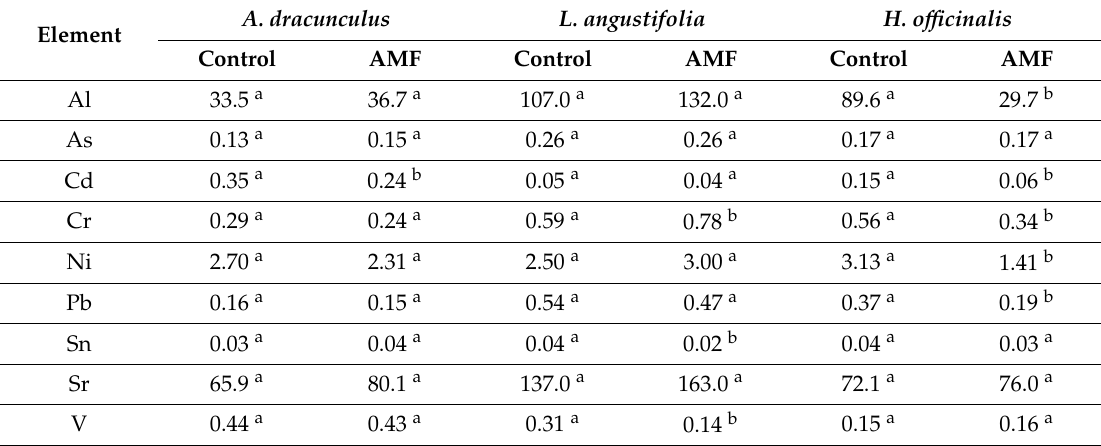
Table 6. Heavy metals content in aromatic plants inoculated with AMF (mg · kg -1 d.w.).